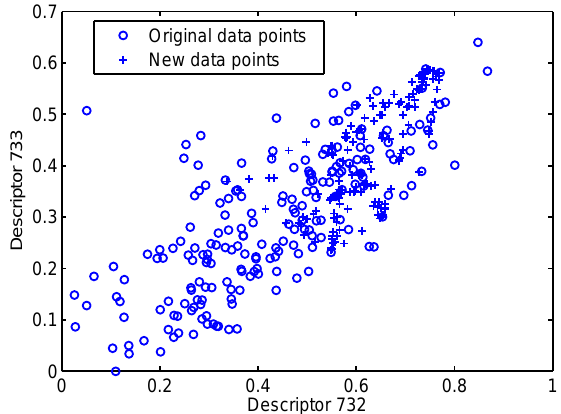
Figure 2. Two-descriptors plot of the training dataset after data augmentation.